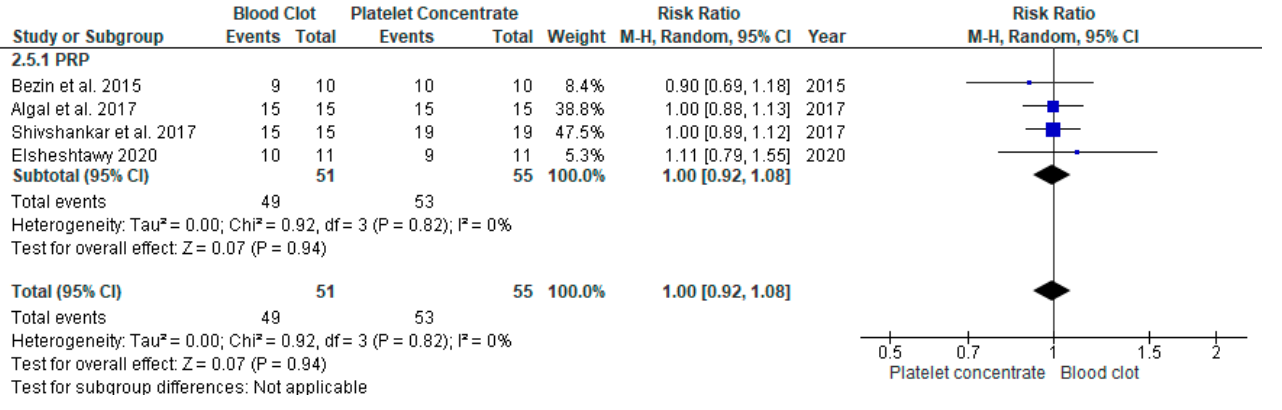
Figure 8. Meta-analysis of success rate in regenerative endodontic procedure (REP) using APC or BC.